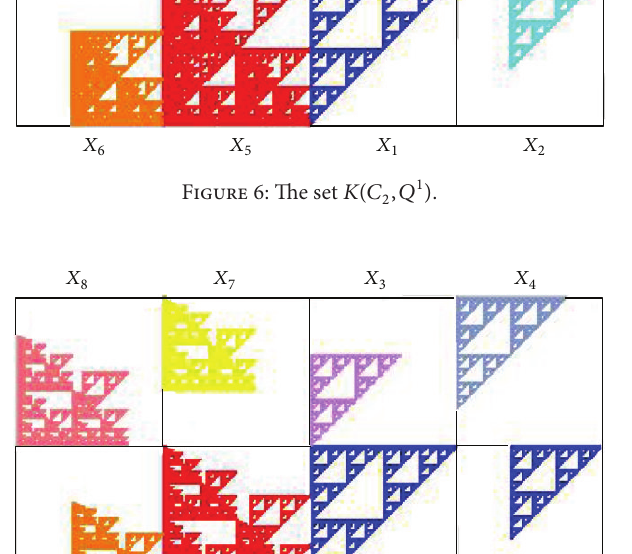
Figure 7: The set 𝐾(𝐶 2 ,𝑄 2 )